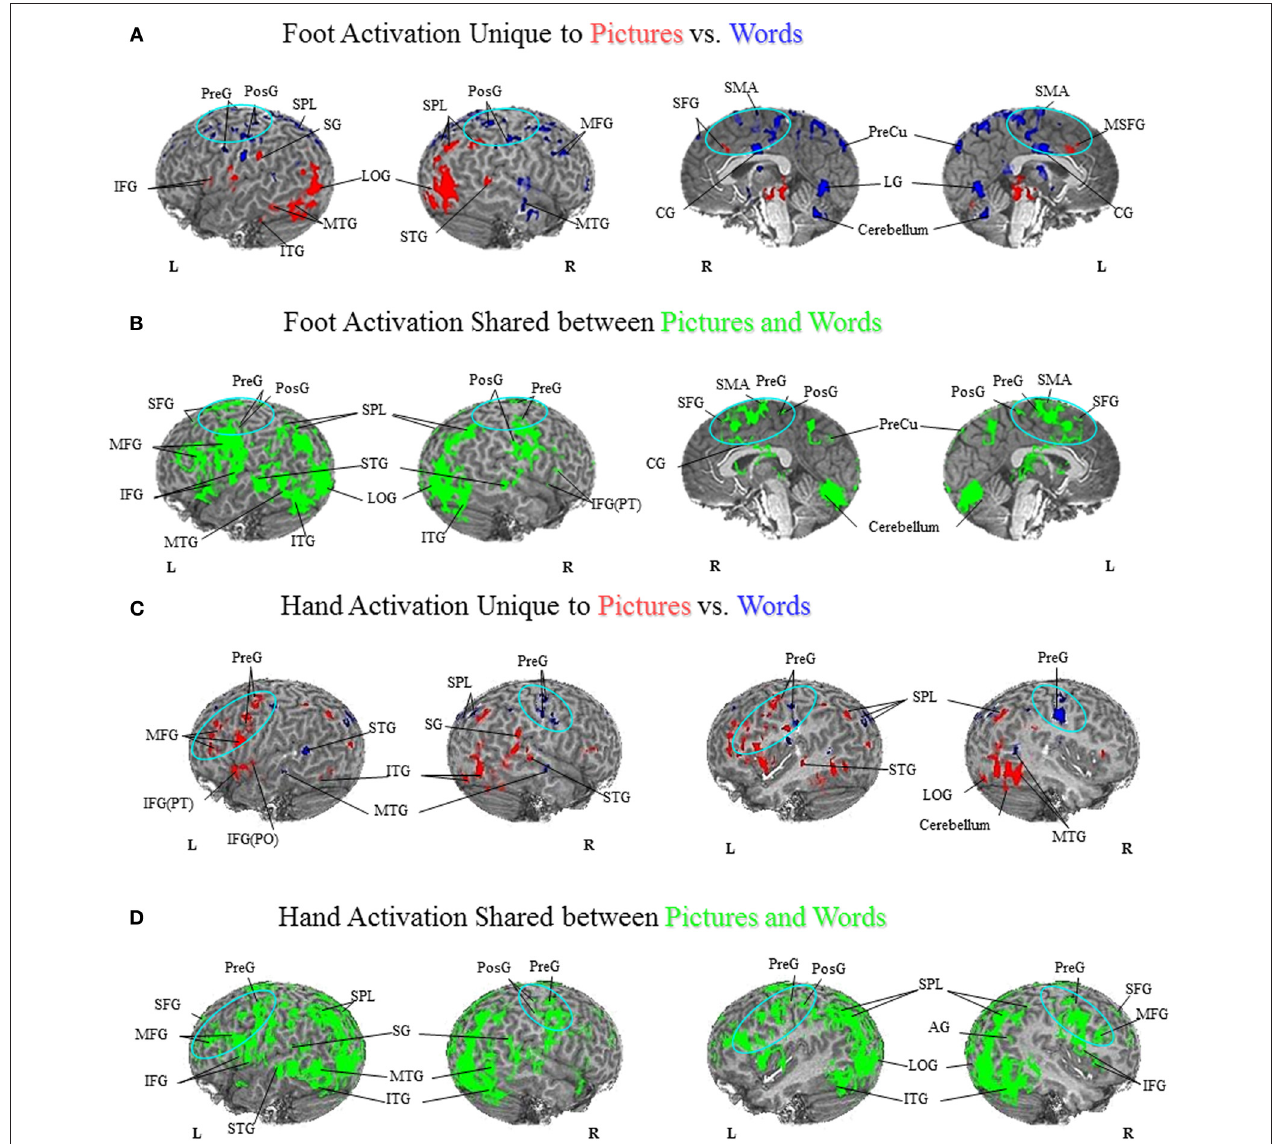
FIGURE 3 | Semantic Generation of Pictures versus Words. (A) Foot Activation Unique to Pictures vs. Words. For the semantic generation to foot picture stimuli (red coded activation), activation was found in the left IFG and SG and right IPL on the lateral surface, and bilateral SFG along the midline. For the semantic generation to foot word stimuli (blue coded activation), unique activation was found in bilateral PreG, PosG and SPL, and right MFG on the lateral surface, and bilateral SMA, CG, and PreCu, as well as right SFG along the midline. Regions of unique activation for the semantic generation to foot picture stimuli outside the PFN were found in the bilateral LOG, the left ITG and MTG, and the right STG on the lateral surface. Regions of unique activation for the semantic generation to foot word stimuli outside the PFN were found in the right MTG on the lateral surface, and bilateral lingual gyrus and cerebellum along the midline. (B) Foot Activation Shared between Pictures and Words. Shared activation between the semantic generation to foot picture stimuli and foot word stimuli (green coded activation) was found in bilateral PreG, PosG, PMC, IFG, and left SPL, AG, MFG, and SFG, on the lateral surface. Activation was also found in bilateral SFG, SMA, PreG, PosG, CG and PreCu, along the midline. Regions of shared activation for the